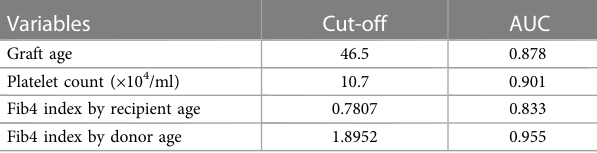
TABLE 3 Cut-off values of continuous variables for graft fi brosis